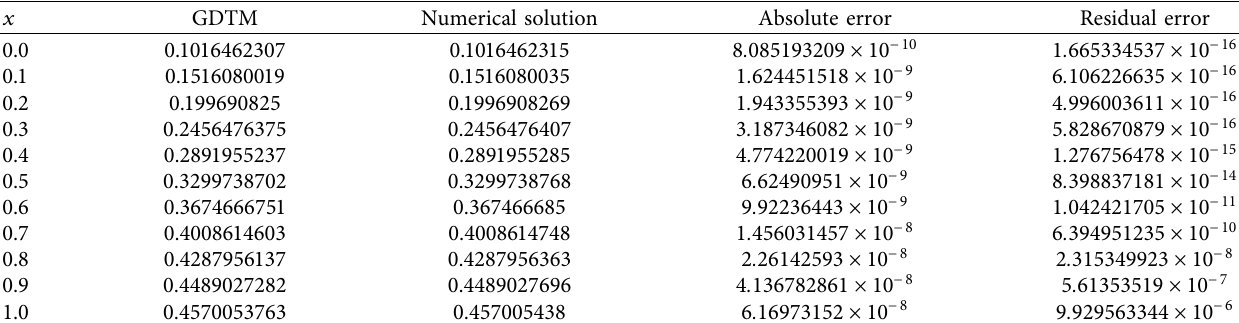
Table 3: GDTM solution and numerical solution with its absolute and residual errors for λ � 5 , μ � 0 . 7 , β � 0 .